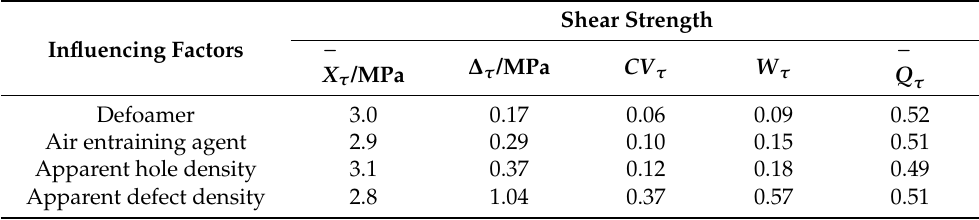
Table 7. Weight and average membership degree of factors affecting shear strength of